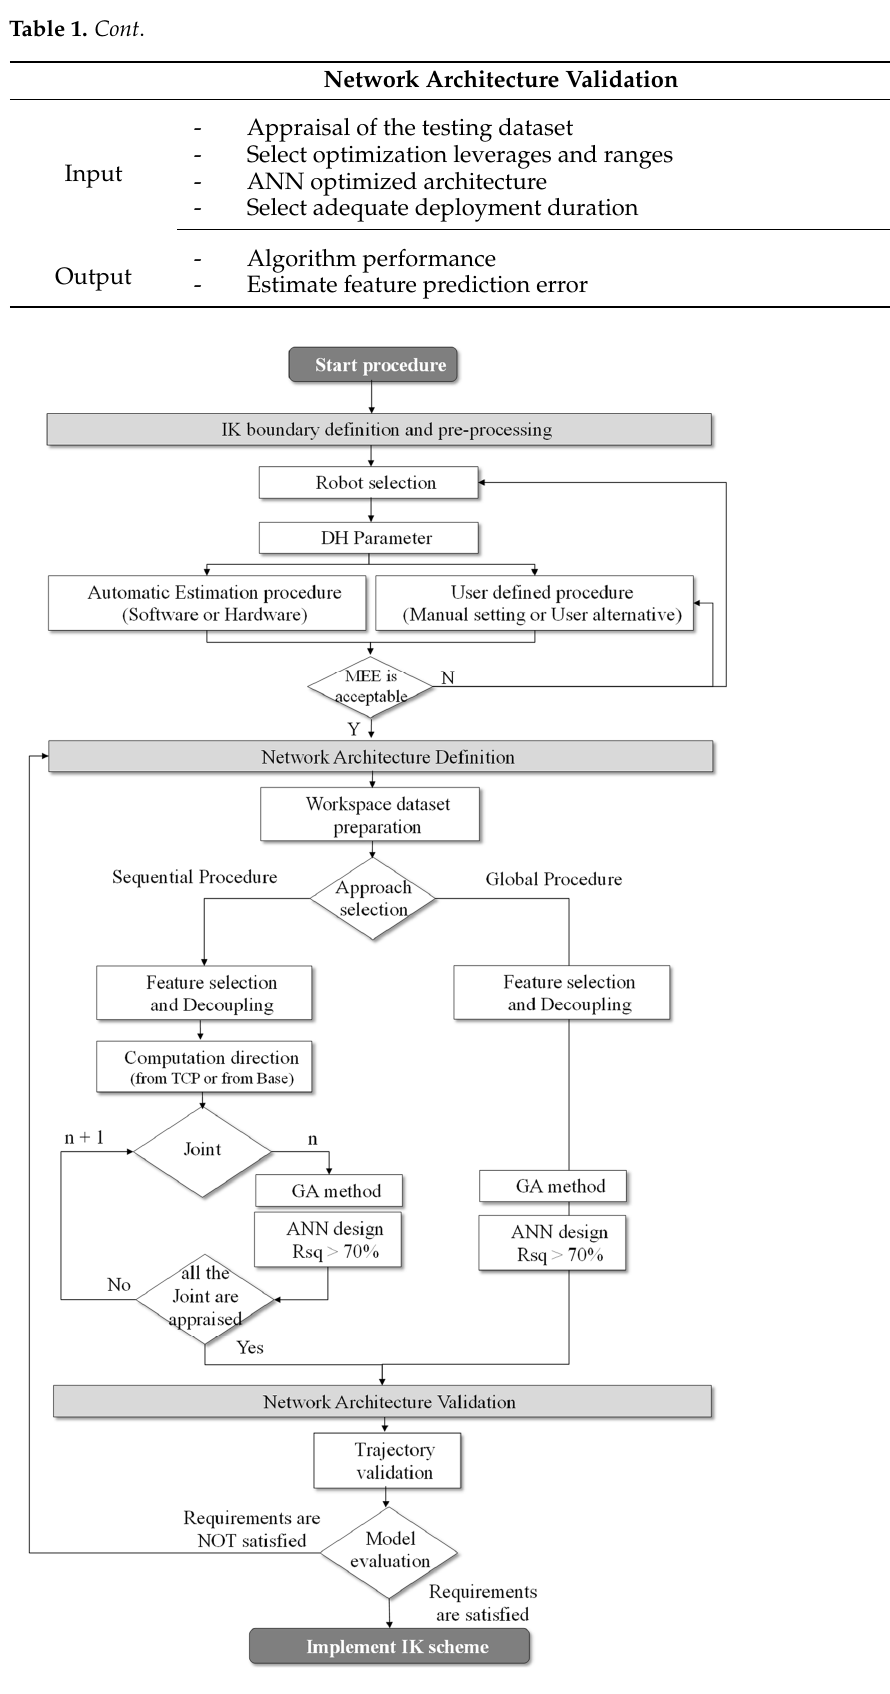
Figure 1. Flow diagram of the IK procedure.